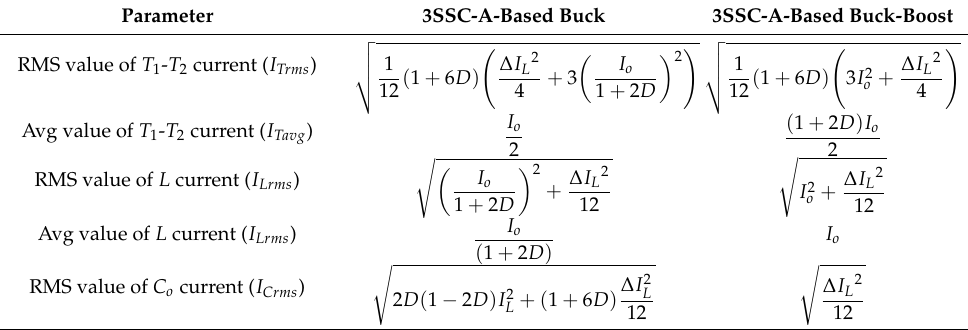
Table 2. Average and RMS components currents for 3SSC-A-based buck and buck-boost converters. Parameter 3SSC-A-Based Buck 3SSC-A-Based